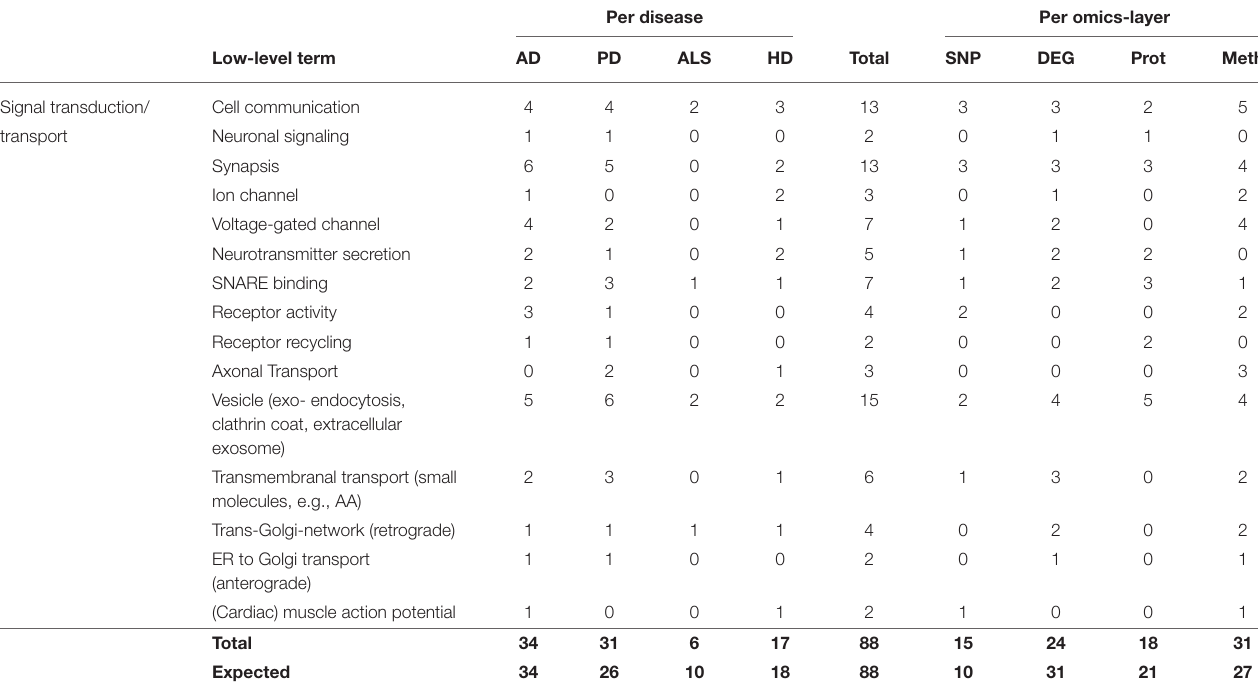
TABLE 6 | Accumulated number of low-level terms per NDD and per omics-layer for the hallmark Signal Transduction/Transport. Per disease Per omics-layer Low-level term AD PD ALS HD Total SNP Meth Signal transduction/ Cell communication transport